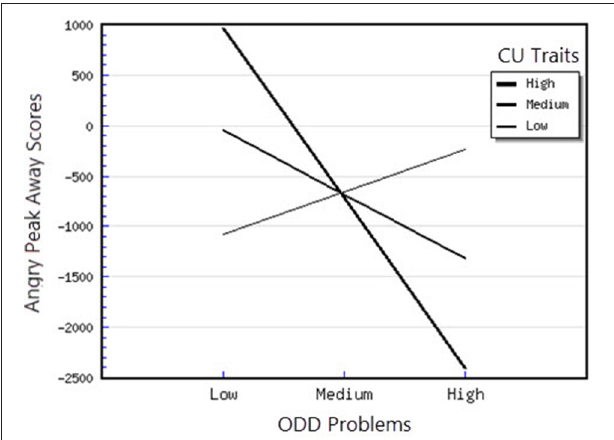
FIGURE 2 | Interaction between CU traits and anxiety in predicting angry peak toward scores.